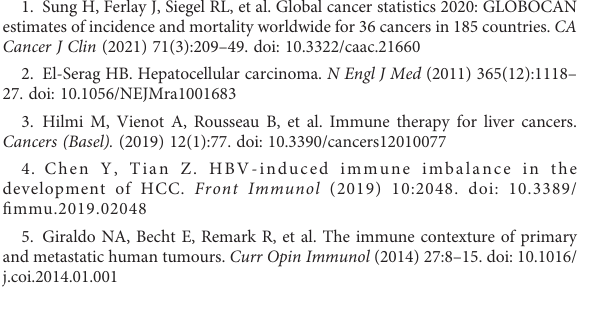
SUPPLEMENTARY FIGURE 1 Comparison of immune cell in fi ltration in tumor section Heat map showed the tissue in fi ltration ratio of 23 types of immuno cells in each HCC sample SUPPLEMENTARY FIGURE 2 Expression levels of immune-related genes in cold and hot tumors (A) . Venn diagram showed the number of immune-related genes that are highly expressed in hot tumors (B) . Venn diagram showed the number of highly expressed immune-related genes in cold tumors SUPPLEMENTARY FIGURE 3 Background correction, normalization for different datasets (A) . PCA analysis showed sample differences before background correction of the dataset (B) . PCA analysis showed sample normalization after dataset background correction SUPPLEMENTARY FIGURE 4 KM curve between survival time and risk score of 30 HCC